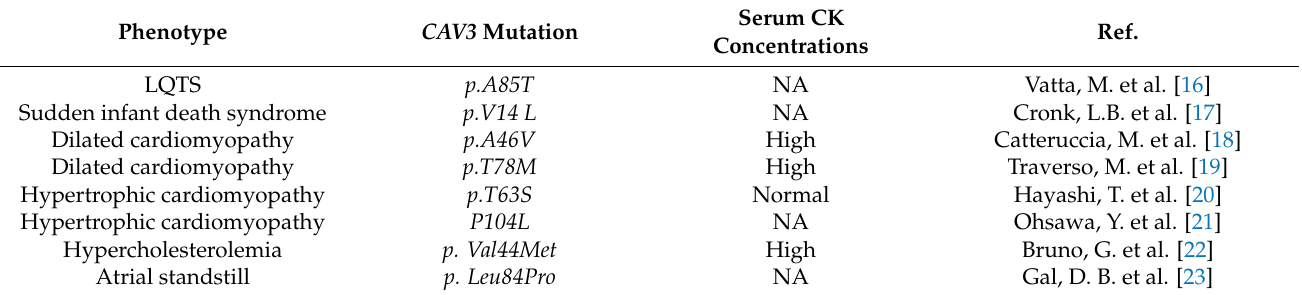
Table 1. Pathogenic CAV3 mutation associated with cardiovascular